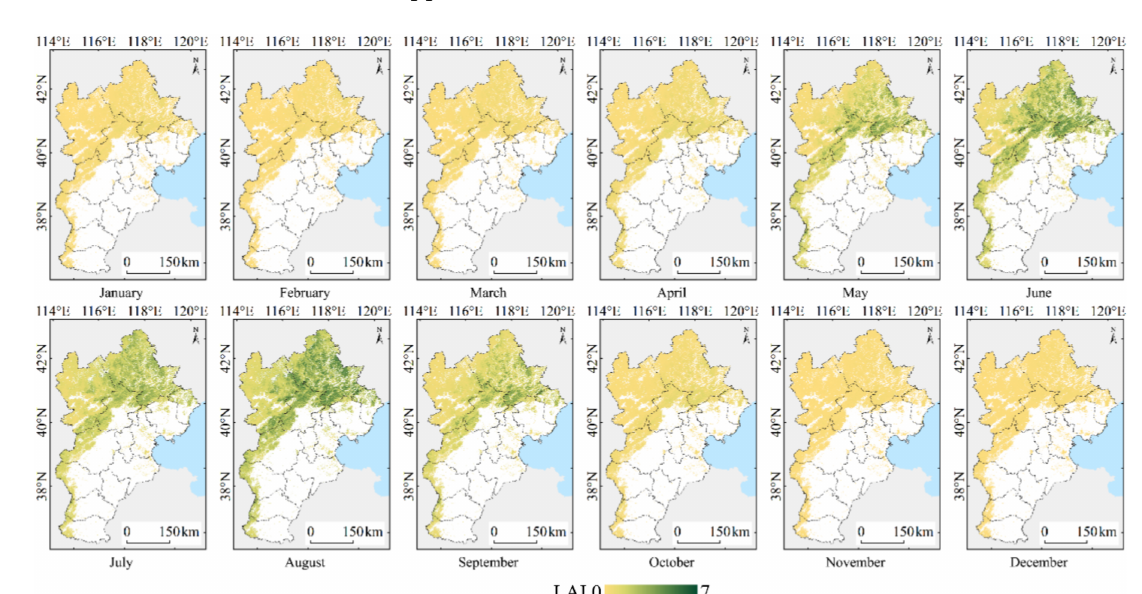
Figure 7. Spatial distribution of monthly mean values of LAI from 2015 to 2018.